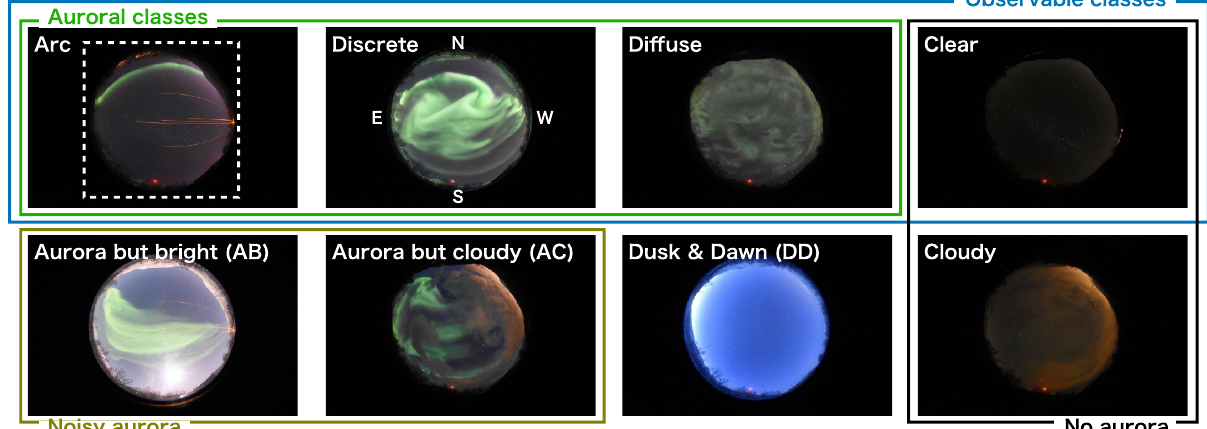
Figure 1. Sample images of the eight classes for the differentiation of all-sky images. The white dashed square in the image of the Arc class indicates the region used for training. For statistical analysis, we defined the auroral occurrence rate as the ratio of the Auroral classes ( Arc, Discrete, and Diffuse ) to the Observable classes ( Auroral + Clear ). Noisy aurora and No aurora classes are used in the bottom panel of Fig.